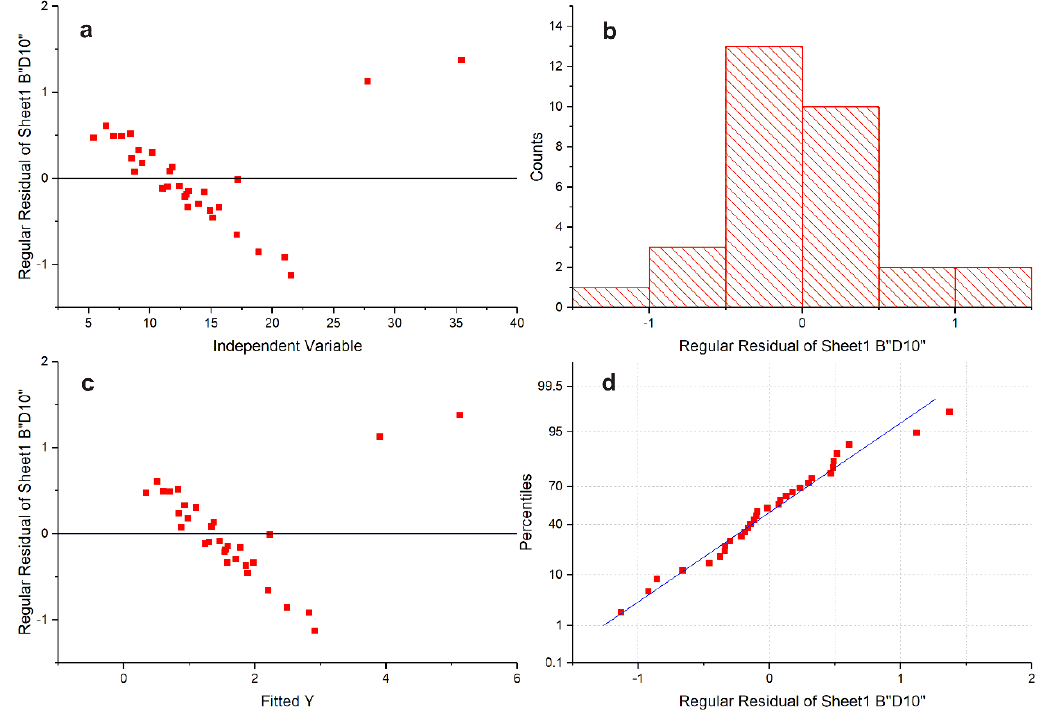
Figure 5. Residuals characteristic parameter D10; regional samples: ( a ) shows scatter plot of residuals; ( b ) shows histogram of regular residual; ( c ) shows scatter plot of residuals with fitted Y; and ( d ) shows scatter plot of residual flatten and significance testing.